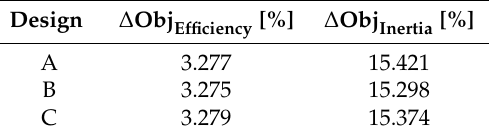
Figure 12. Objective space of the moment of inertia and total-to-static efficiency ( left ) with a close-up on the Pareto front computed by the gradient-based method ( right ). The three starting designs A, B, and C are randomly selected. Table 3. Comparison of the final aerodynamic and structural objective values relative to the baseline geometry of the three final designs A, B, and C, shown in Figure